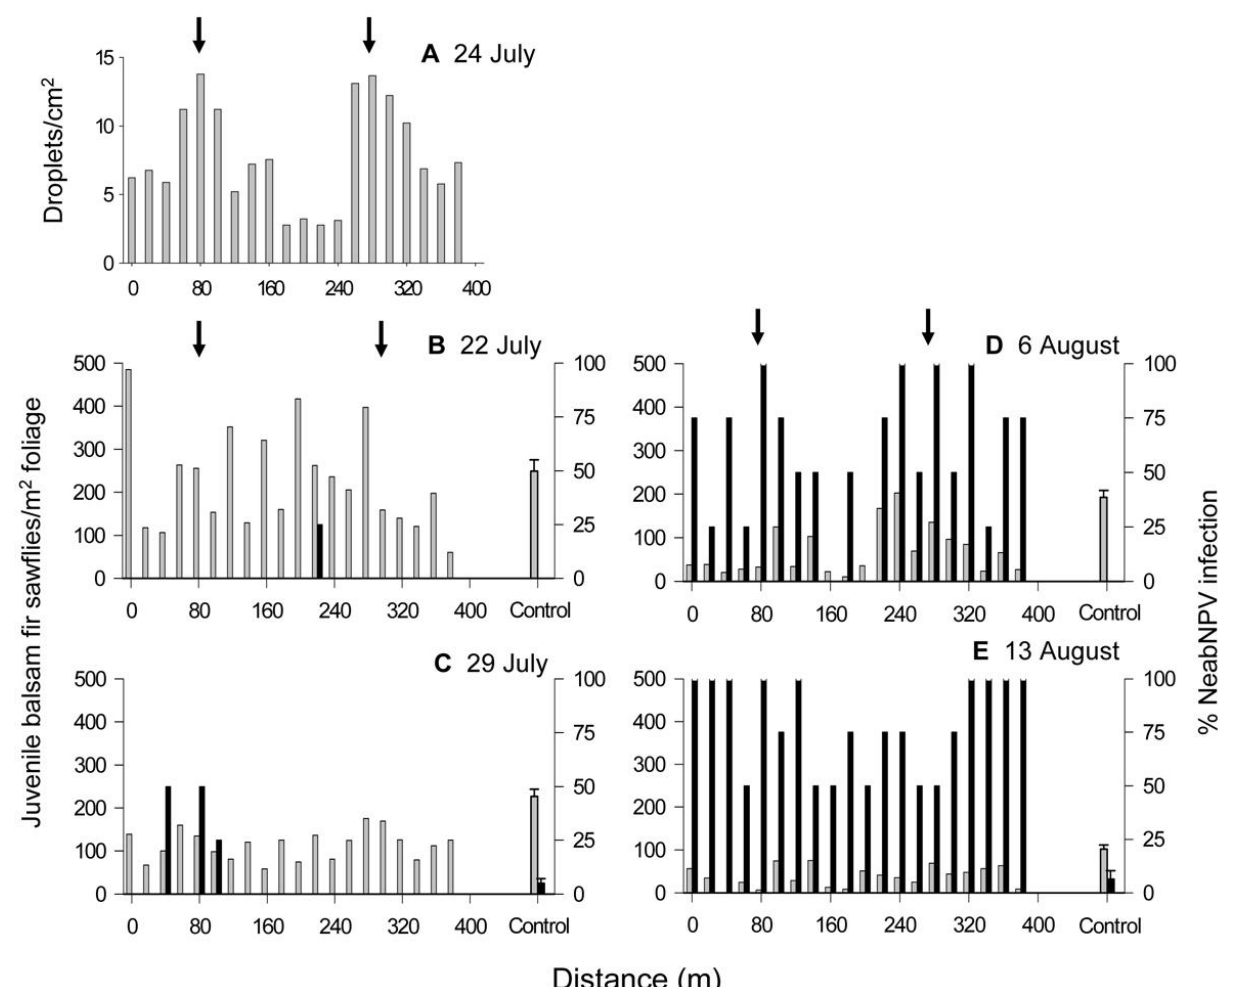
Figure 5. ( A ) Mean spray deposit along a transect line extending 400 m across two 50-m NeabNPV spray swaths (arrows) and a 200-m untreated zone (between arrows) at Old (cid:48)(cid:68)(cid:81)(cid:182)(cid:86)(cid:3)(cid:51)(cid:82)(cid:81)(cid:71)(cid:3)(cid:73)(cid:82)(cid:79)(cid:79)(cid:82)(cid:90)(cid:76)(cid:81)(cid:74)(cid:3)(cid:68)(cid:72)(cid:85)(cid:76)(cid:68)(cid:79)(cid:3)(cid:68)(cid:83)(cid:83)(cid:79)(cid:76)(cid:70)(cid:68)(cid:87)(cid:76)(cid:82)(cid:81)(cid:3)(cid:82)(cid:73)(cid:3)(cid:49)(cid:72)(cid:68)(cid:69)(cid:49)(cid:51)(cid:57)(cid:3)(cid:82)(cid:81)(cid:3) 24 July 2002. Juvenile balsam fir sawfly (larvae and pupae) densities (gray bars) and prevalence of NeabNPV infection (black bars) in the treatment block [same transect line as ( A )] and the untreated control block on ( B ) 22 July, ( C ) 29 July, ( D ) 6 August, and ( E ) 13 August 2002. The densities and infection in the control plots are represented as a mean value (±SEM) because they exhibited no discernable consistent pattern along the